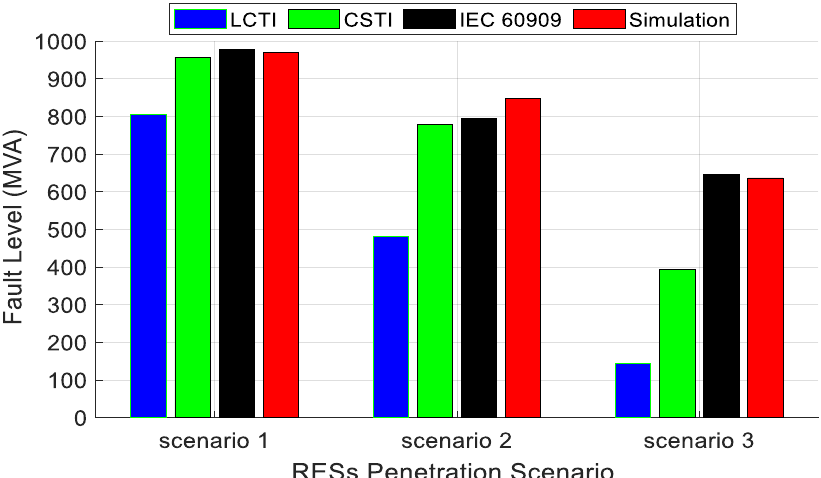
Figure 6. Bus six fault level in different penetration scenarios.